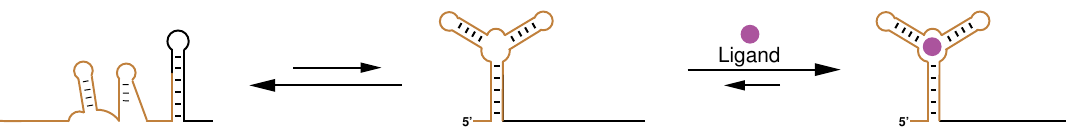
Figure 1. Illustration of the general riboswitch mechanism. Typically, two structural alternatives ( left and middle ) dominate the ensemble of a riboswitch sequence. The one that contains the correctly folded aptamer structure ( middle ) is further stabilized upon ligand addition and the system gets trapped in the bound conformation ( right